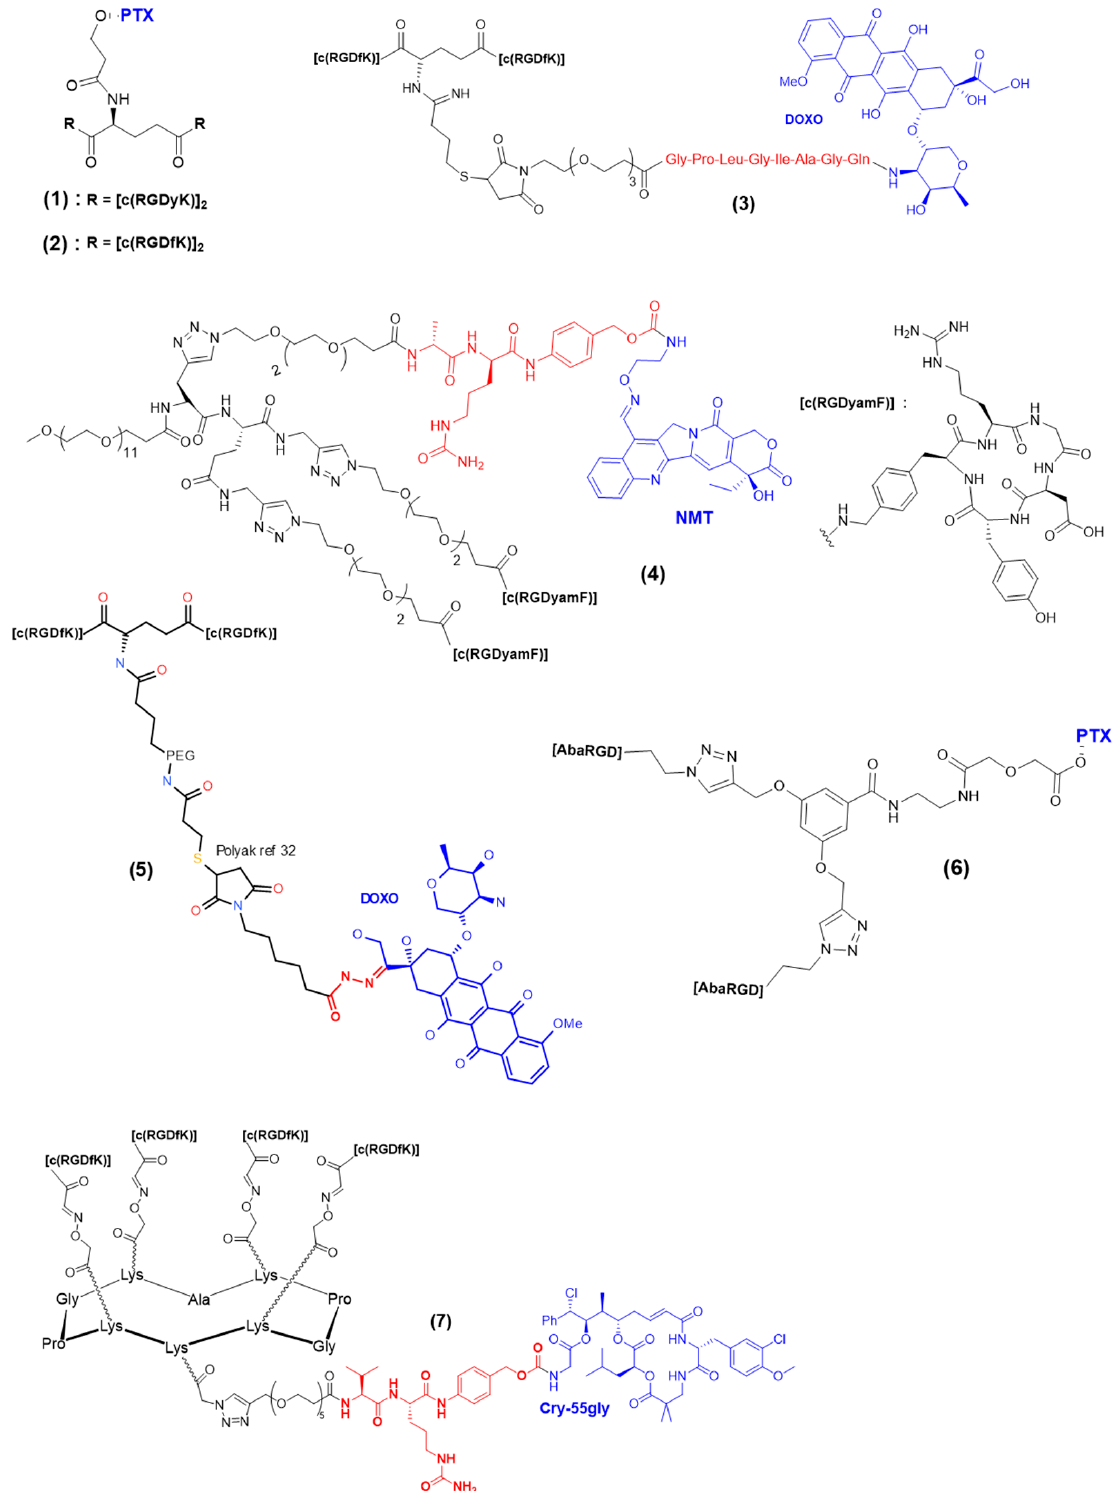
Figure 4. Multimeric RGD conjugates encompassing cleavable linkers.